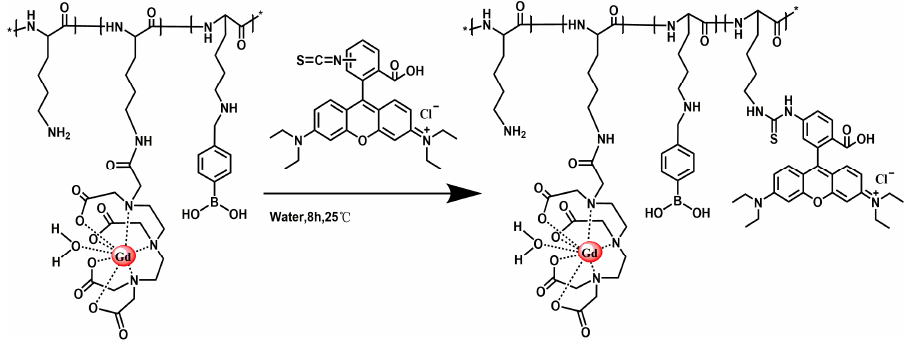
Figure 8. Synthesis route of PLL-B-DTPA-Rodamine.